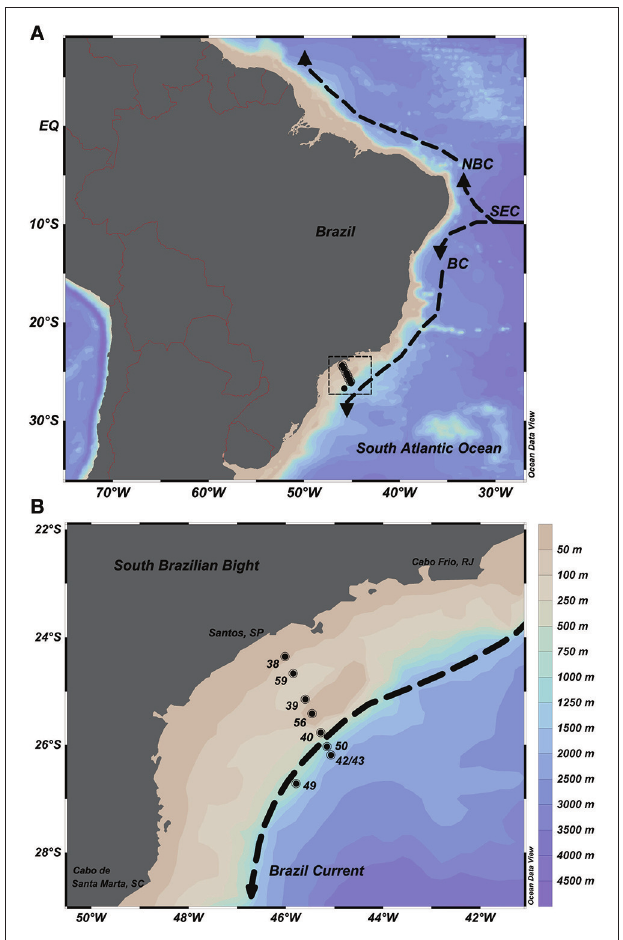
FIGURE 2 | Sampling map on the Brazilian continental shelf, Southwestern Atlantic Ocean. (A) Basic scheme of circulation: The South Equatorial Current (SEC) bifurcates into the North Brazil Current (NBC) and the Brazil Current (BC). (B) Oceanographic stations sampled in January 2013 (black dots), bathymetry of the South Brazilian Bight and the Brazil Current flowing southward (dashed arrow).